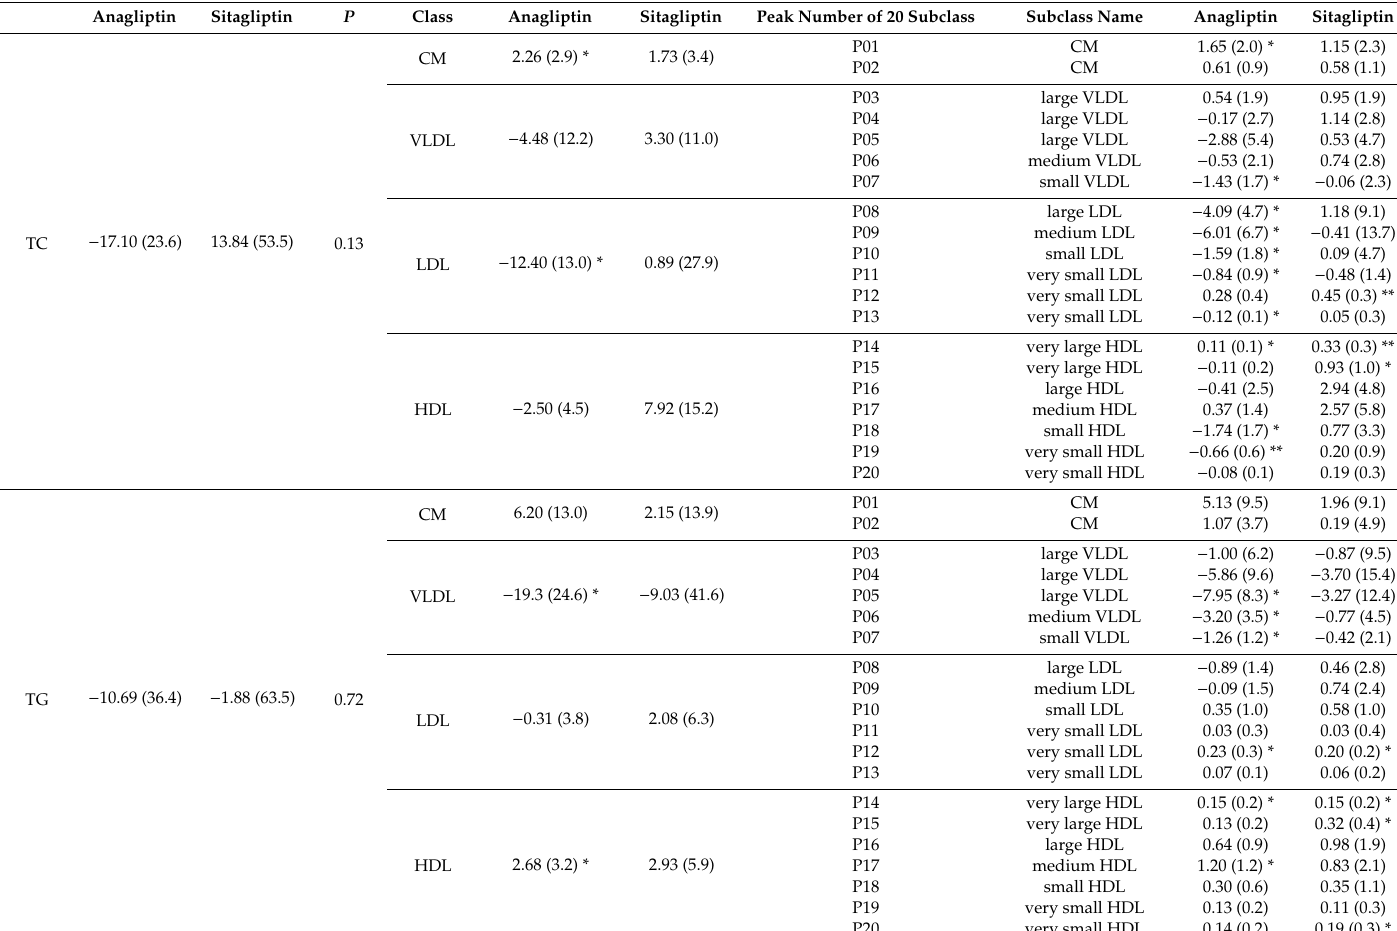
Table 3. Di ff erences in total cholesterol and triglycerides in lipoprotein classes and subclasses in patients treated either with anagliptin or sitagliptin. Standard statin